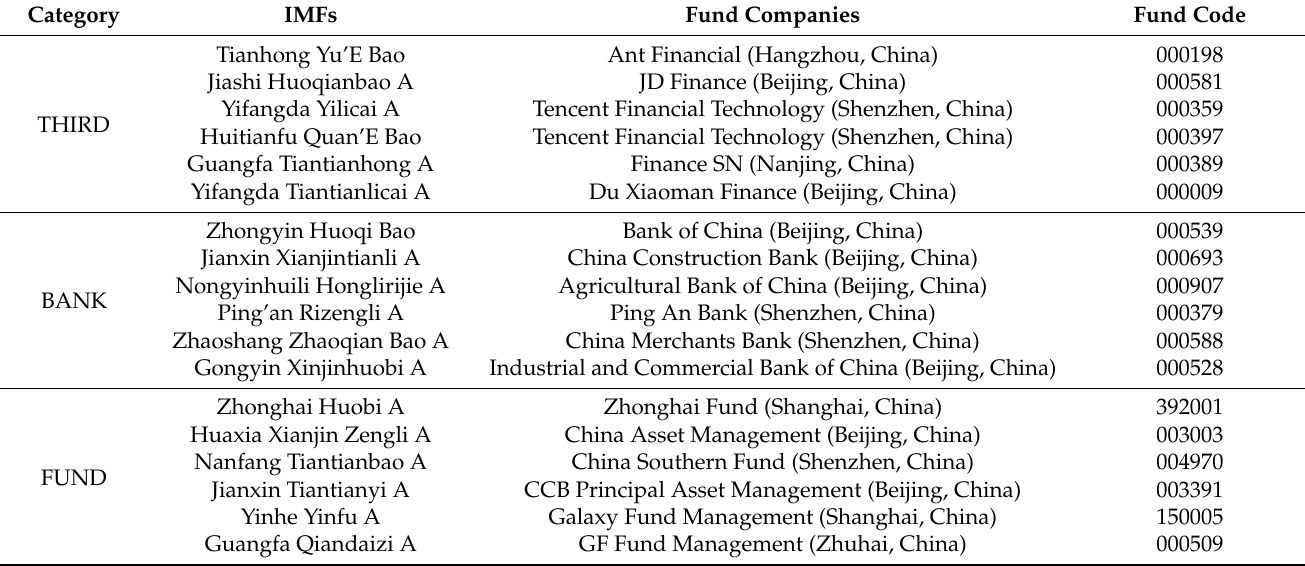
Table 1. Basic information of the IMF